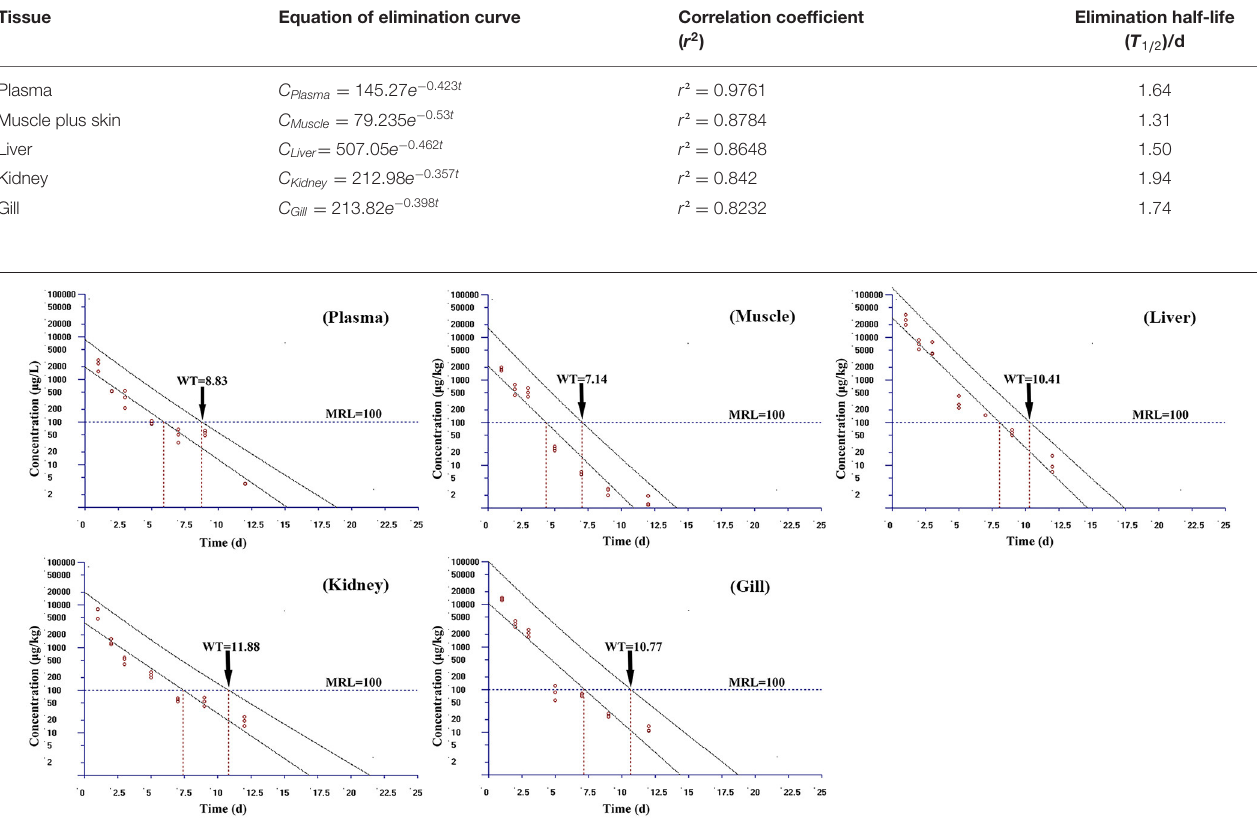
FIGURE 2 | The withdrawal time (WT) of tiamulin in plasma, muscle plus skin, liver, kidney, and gill at 19 ◦ C calculated by WT 1.4 software.